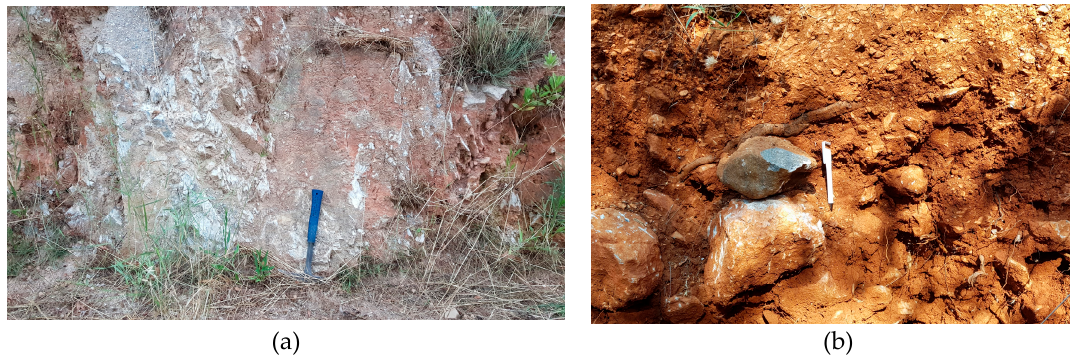
Figure 4. ( a ) Dolomitic-limestone with minor karst features in the south; ( b ) matrix supported colluvium and medium-large dolomitic limestone fragments in the east.